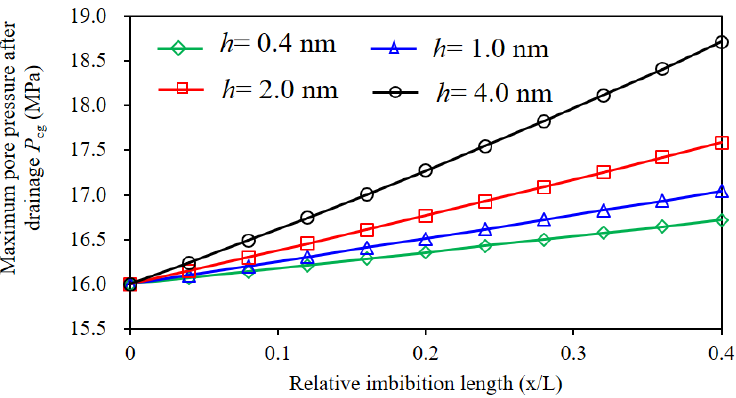
Figure 6. Effect of imbibition on the maximum pore pressure after drainage.